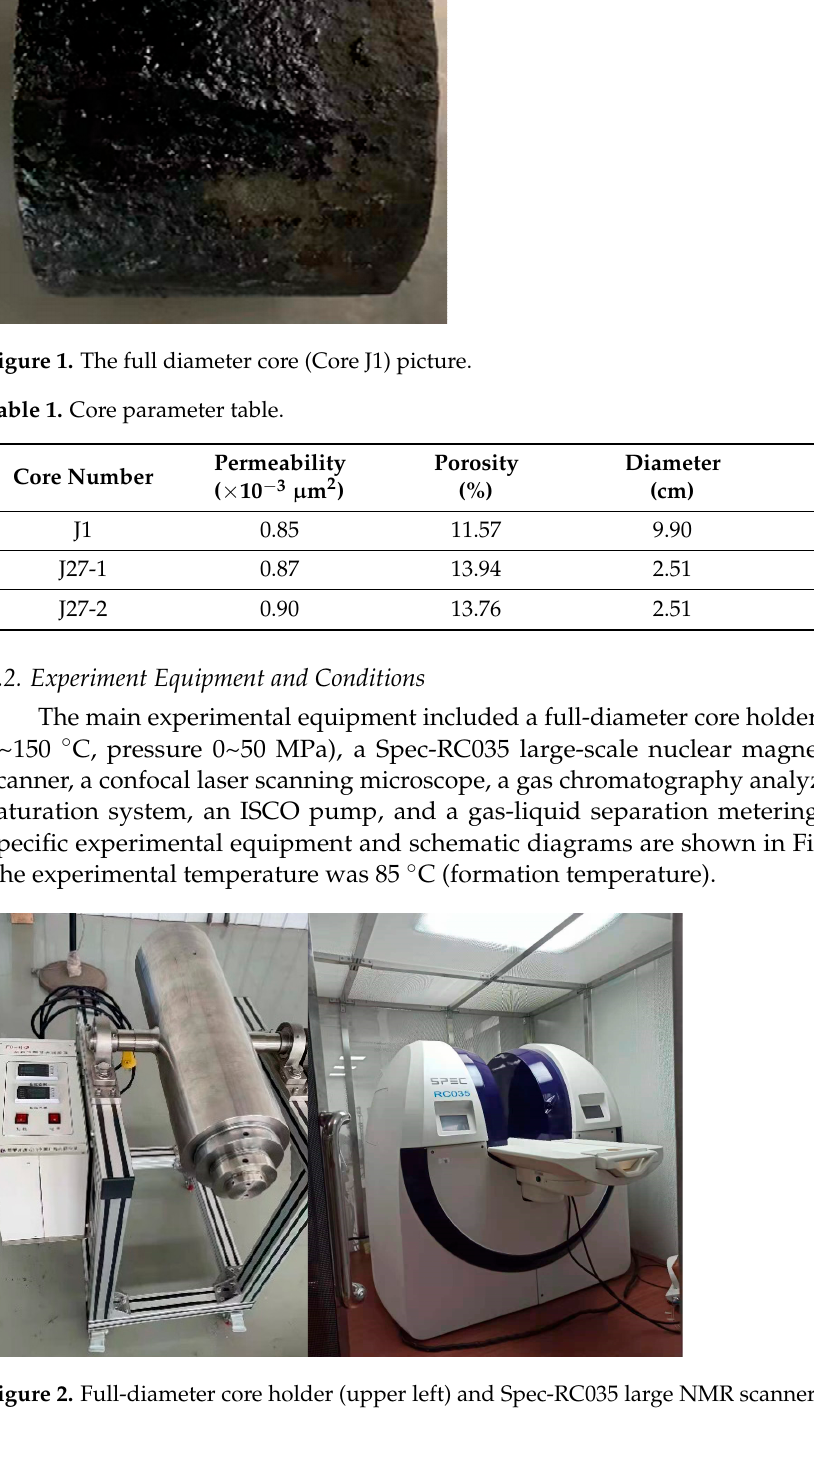
Figure 2. Full-diameter core holder (upper left) and Spec-RC035 large NMR scanner (upper right).